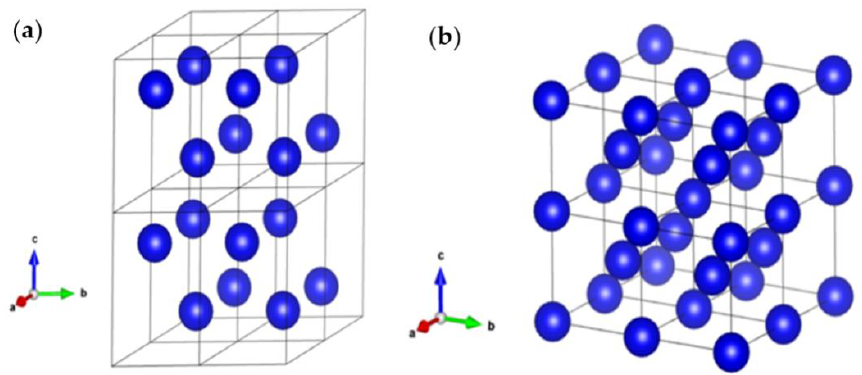
Figure 1. ( a , b ) crystal structures and crystallographic information of α and β phases in Zr